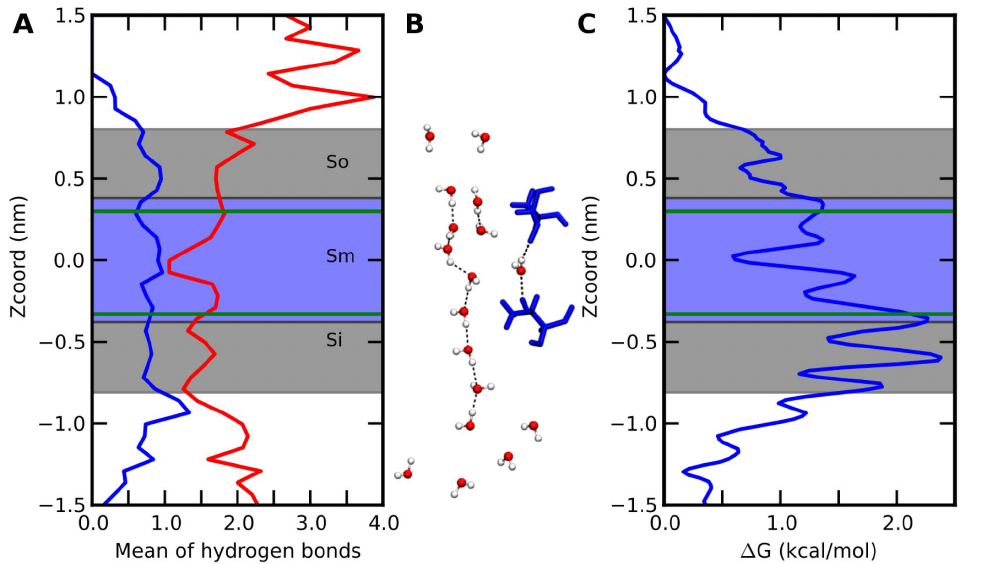
Figure 6. Hydrogen bonds and potential of mean force of water in the pore. (A) The average number of hydrogen bonds over the MD simulation between water and, in blue, the protein and, in red, the water molecules. (B) Snapshot of water molecules’ organization in the lumen of the pore, with the hydrogen bond network. Thr177 and Thr339 are displayed in blue. (C) Potential of Mean Force of a water molecule along the pore calculated from the water density. Green lines indicate the average z-coordinate of CG atoms for Thr177 and 339, over the three subunits. Residues in stick define sub-site along pore axis.